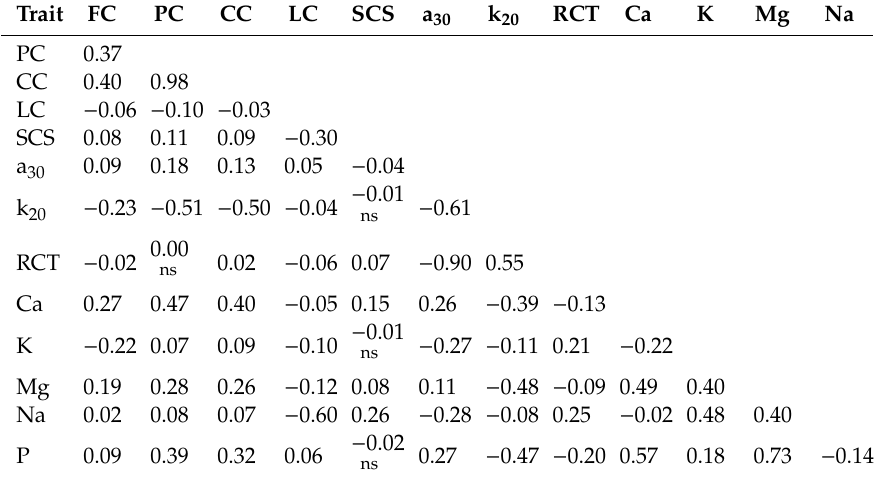
Table 2. Pearson correlations ( p < 0.05) between bulk milk composition traits, coagulation properties, and mineral content (mg / kg).